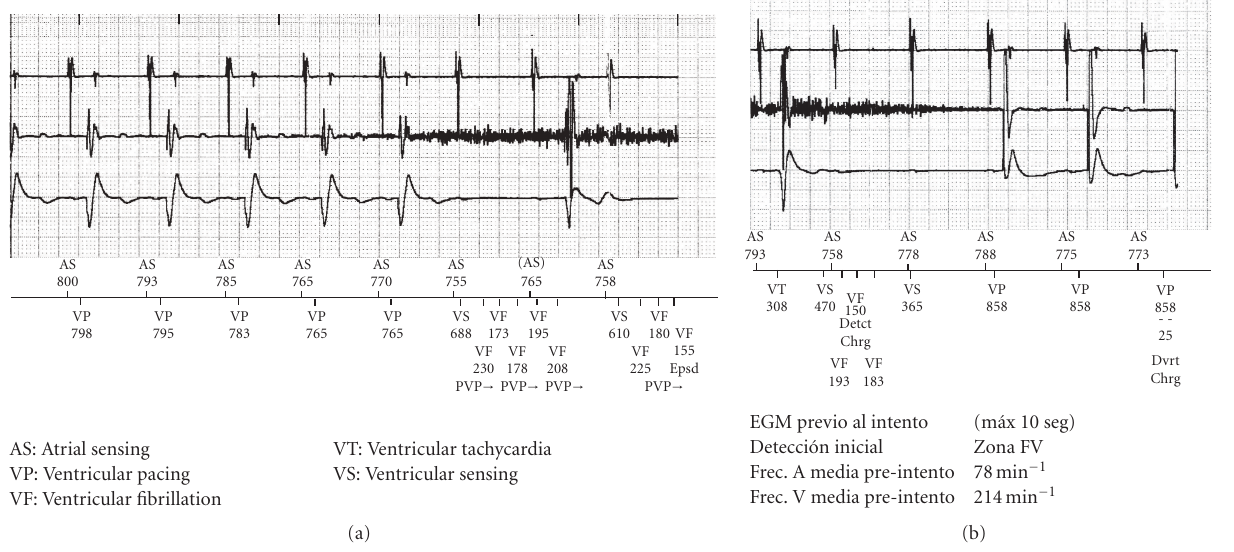
Figure 3: Electrograms of episode 460. Oversensing due to artifacts that start capacitors charge and provoke ventricular pacing inhibition.